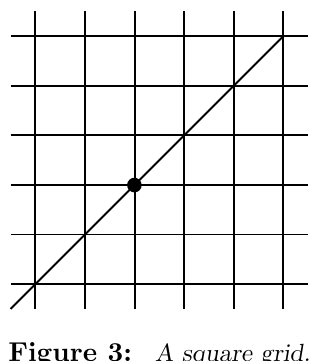
Figure 3: A square